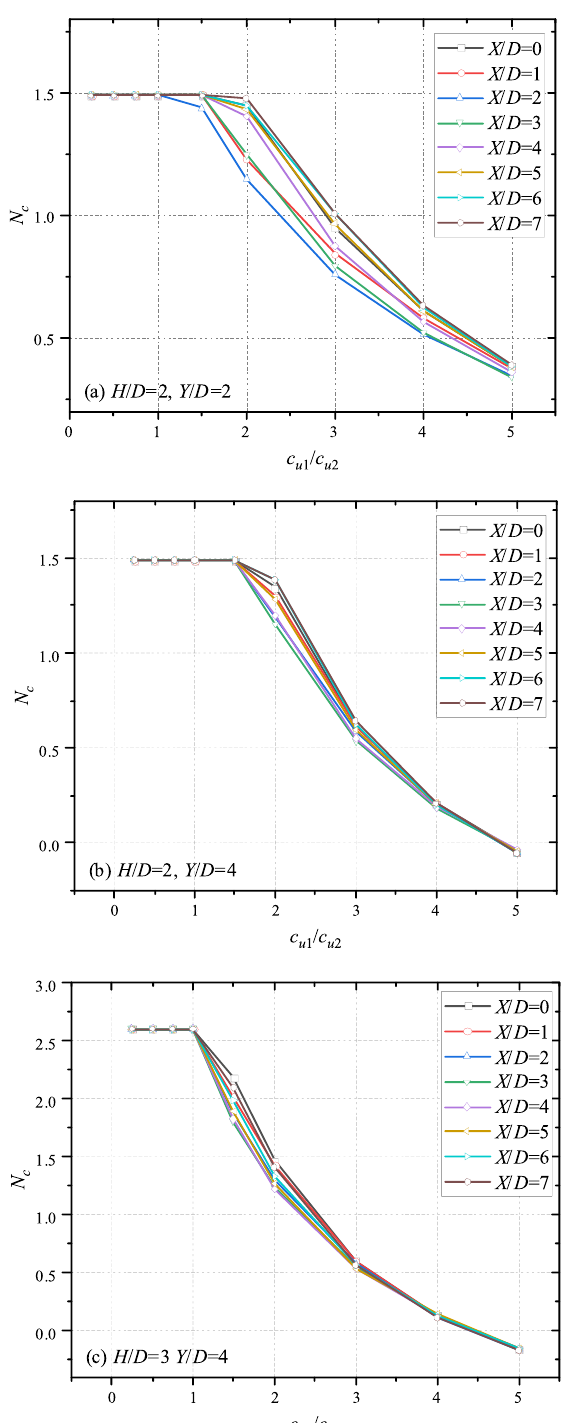
Figure 4. Variation of N c with different c u1 / c u2 and X / D for ( a ) H / D = 2, Y / D = 2; ( b ) H / D = 2, Y / D = 4 and ( c ) H / D = 3, Y / D =